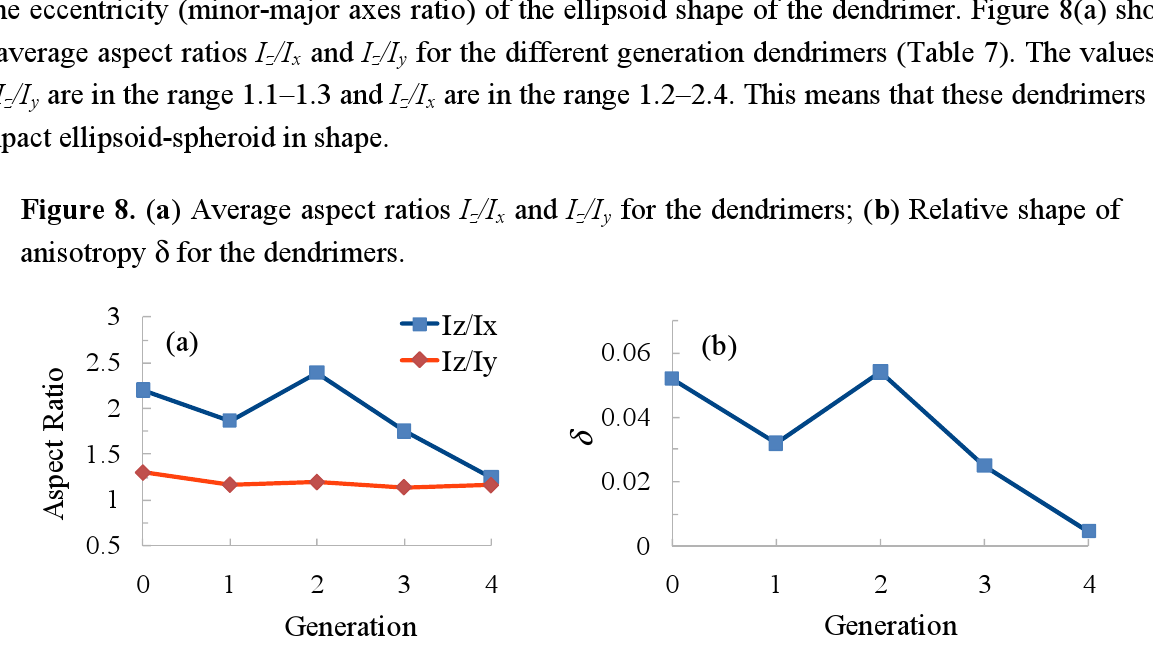
/I and I /I for the dendrimers; ( b ) Relative shape of z x z y